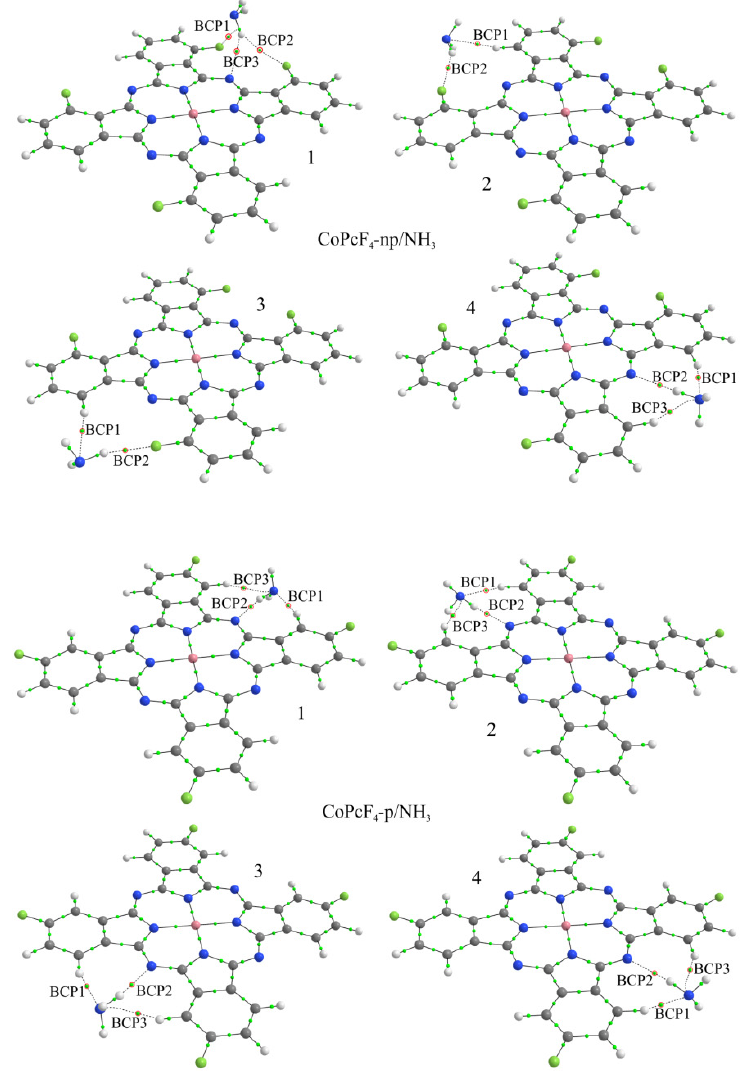
Figure 8. Structure of CoPcF 4 -np/NH 3 and CoPcF 4 -p/NH 3 aggregates and bond critical points (BCP) in them. Red circles indicate BCPs characterizing the interaction of the ammonia molecule with phthalocyanine atoms.